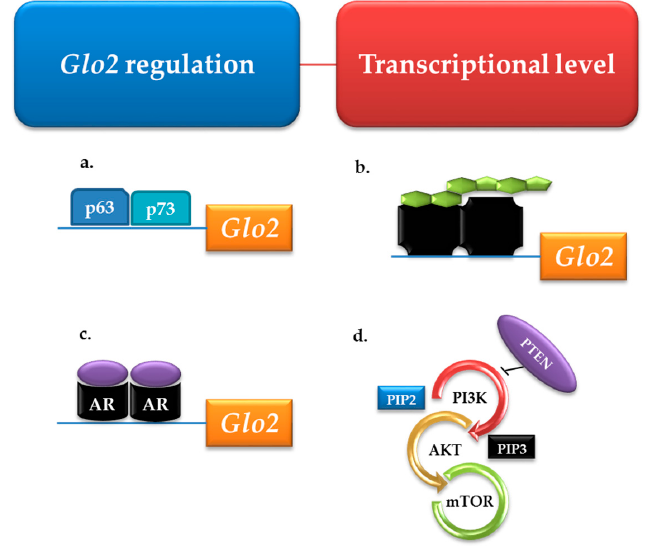
Figure 5. Transcriptional regulation of glyoxalase 2 ( Glo2 ). Transcriptional positive regulators are ( a ) the transcription factors p63 and p73; ( b ) steroid hormones; ( c ) androgen receptor (AR) and ( d )